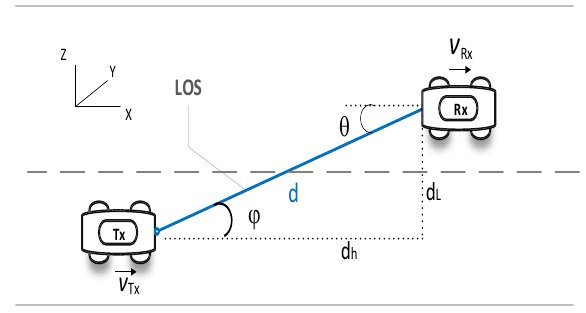
Fig. 2. The V2V system